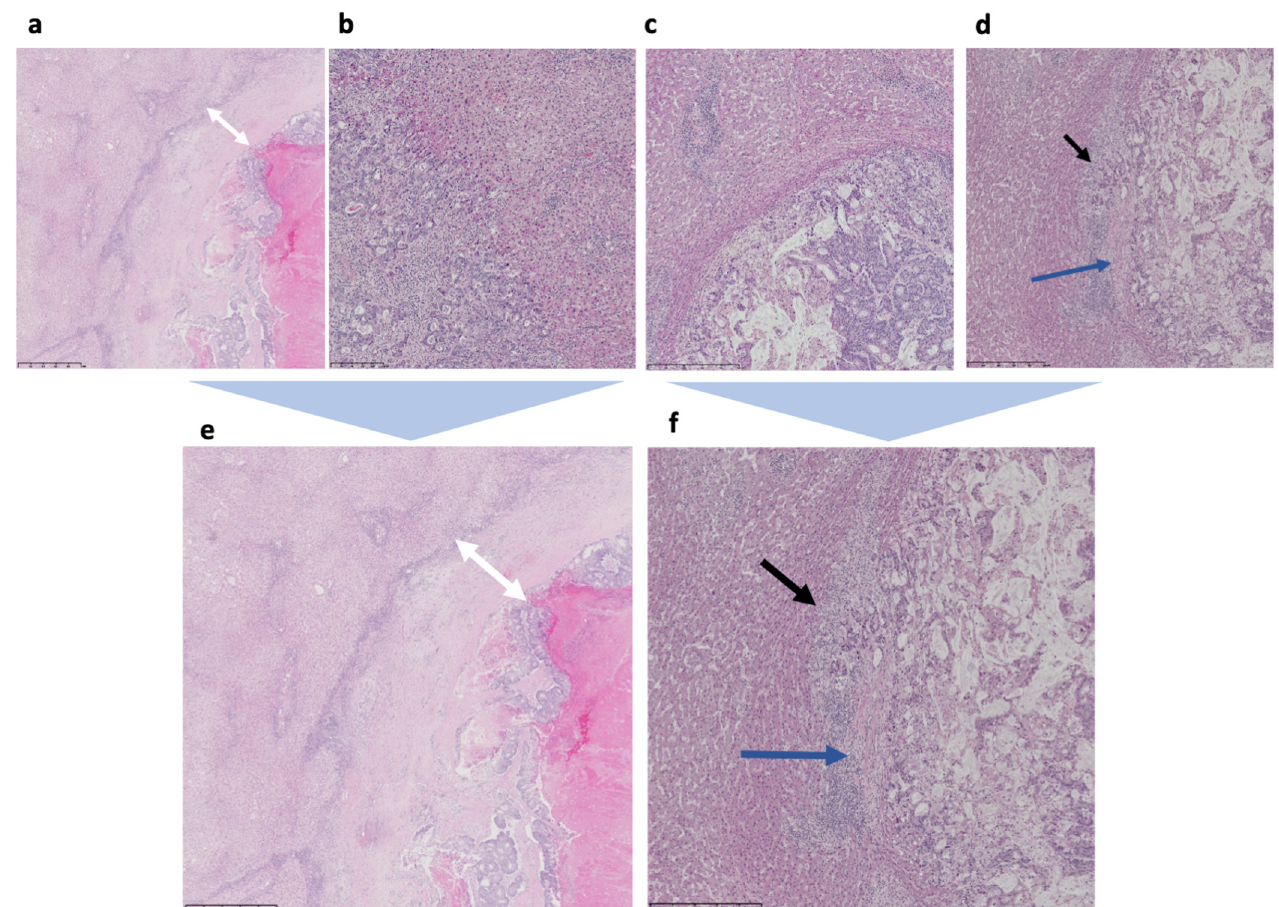
Figure 2. Histopathological growth patterns in a four-tier and two-tier system (H&E images, original data). ( a ) Low magnification of desmoplastic HGP, with white arrows marking the thick fibrous rim that separates the tumor from hepatocytes. ( b ) Low magnification of tumor–liver interface in replacement HGP with cancer cells in continuity with normal hepatocytes. Cancer cells form solid nests and trabeculae and there is no glandular differentiation. ( c ) Low magnification of pushing HGP with sharp interface between tumor cells and adjacent hepatocytes, without desmoplastic rim or tumor cells invading into liver tissue. ( d ) Low magnification of mixed/heterogeneous growth with replacement growth pattern (black arrow) and desmoplastic rim (blue arrow). ( e ) higher resolution of desmoplastic HGP, with white arrows marking the thick fibrous rim that separates the tumor from hepatocytes. ( f ) higher resolution of of mixed/heterogeneous growth with replacement growth pattern (black arrow) and desmoplastic rim (blue arrow). Images are provided by the authors’ clinical series.